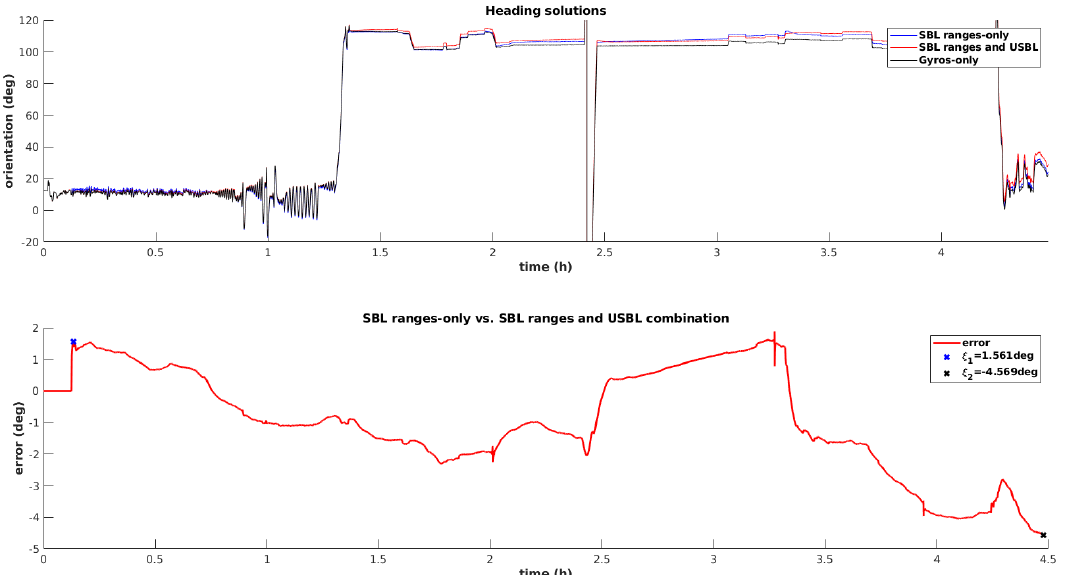
Figure 16. Evaluation of the heading angle estimation using all observation models.